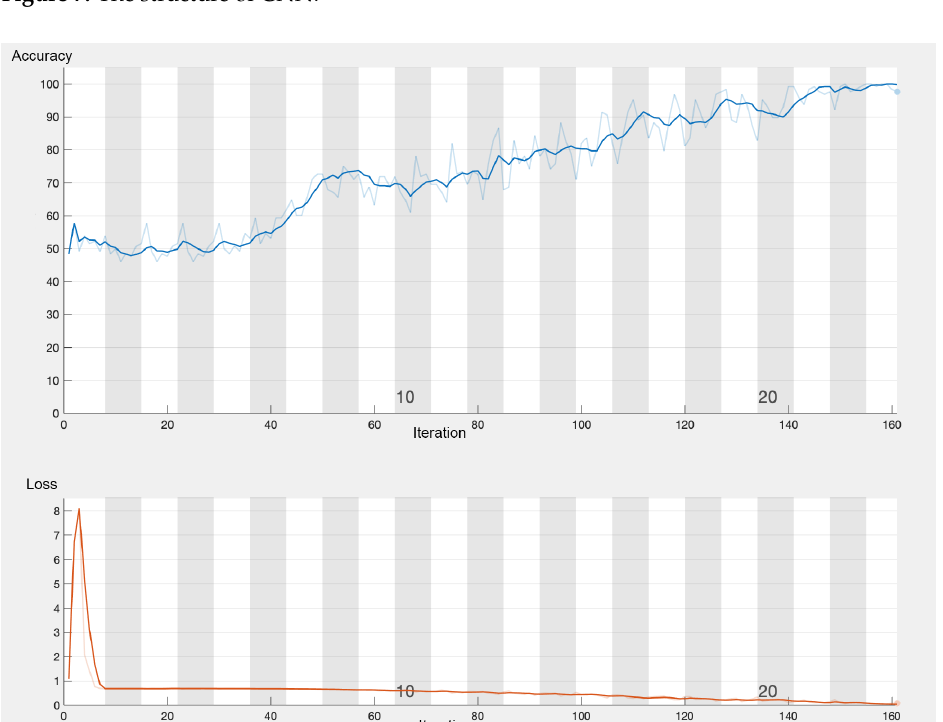
Figure 8. The training process and loss of CNN.